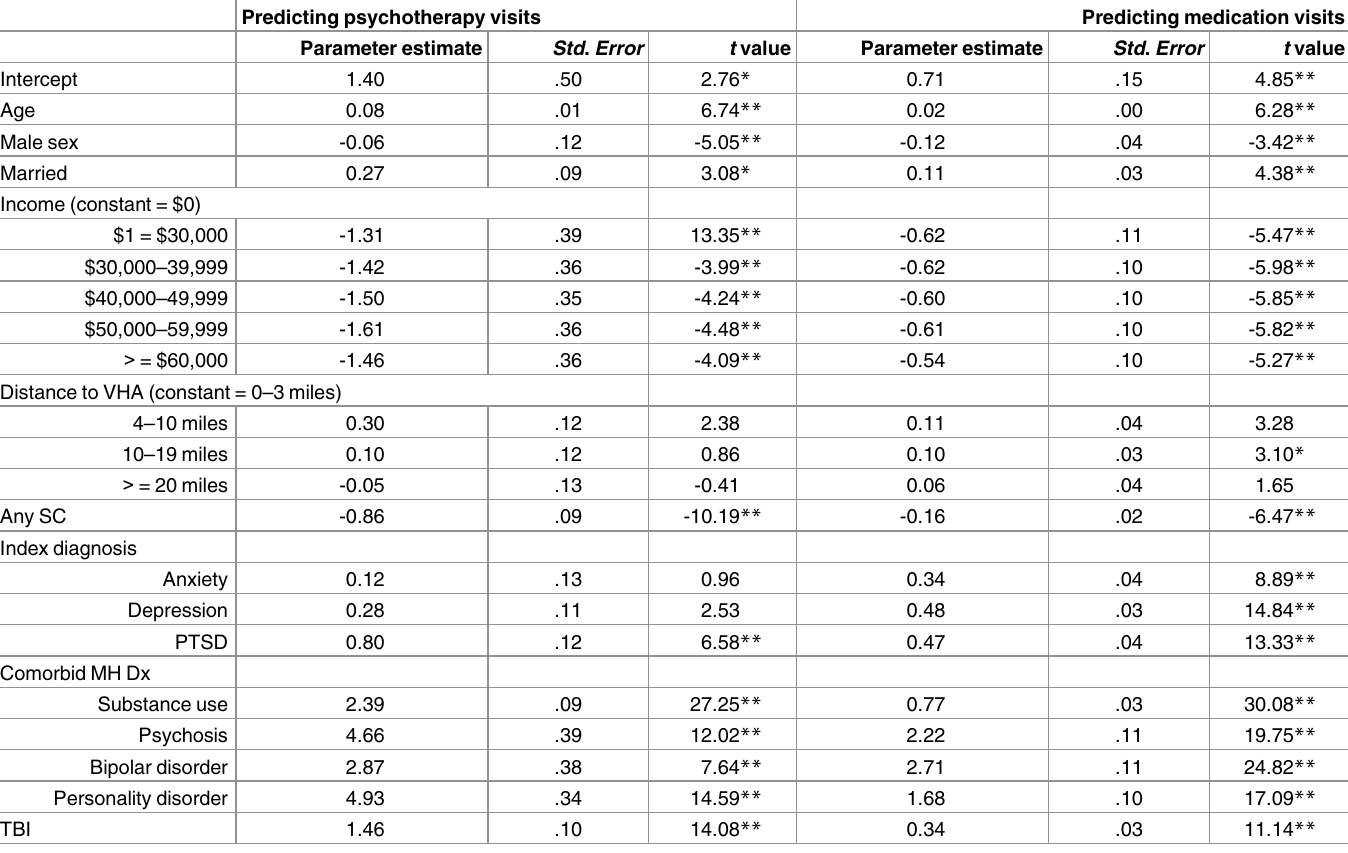
Table 4. Multiple regression predicting number of psychotherapy and medication visits. Predicting psychotherapy